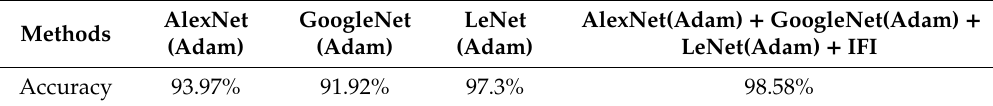
Table 8. Recognition results of di ff erent architectures with Adam optimization method.